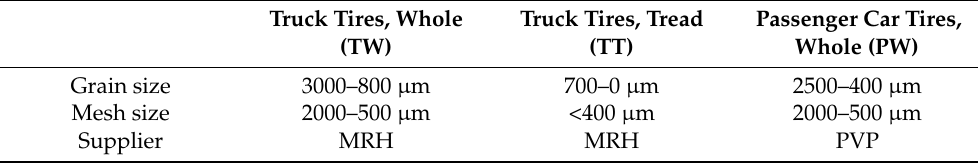
Table 1. Mesh size and supplier of the three end-of-life tire materials.